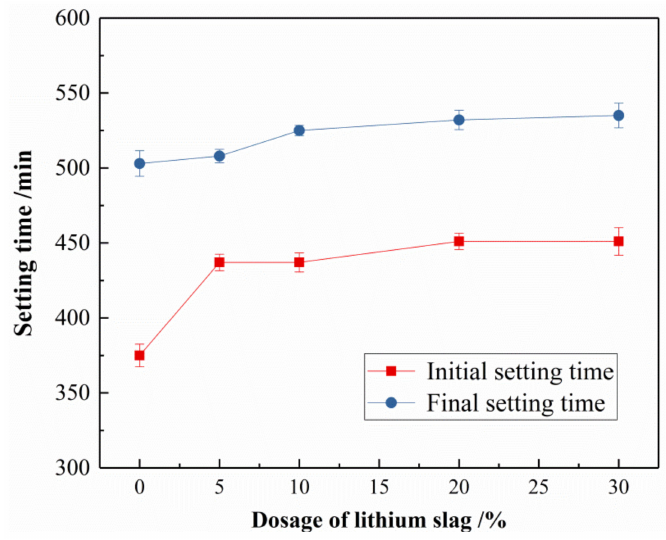
Figure 2. Effect of different dosage of lithium slag on the setting time of MOC.